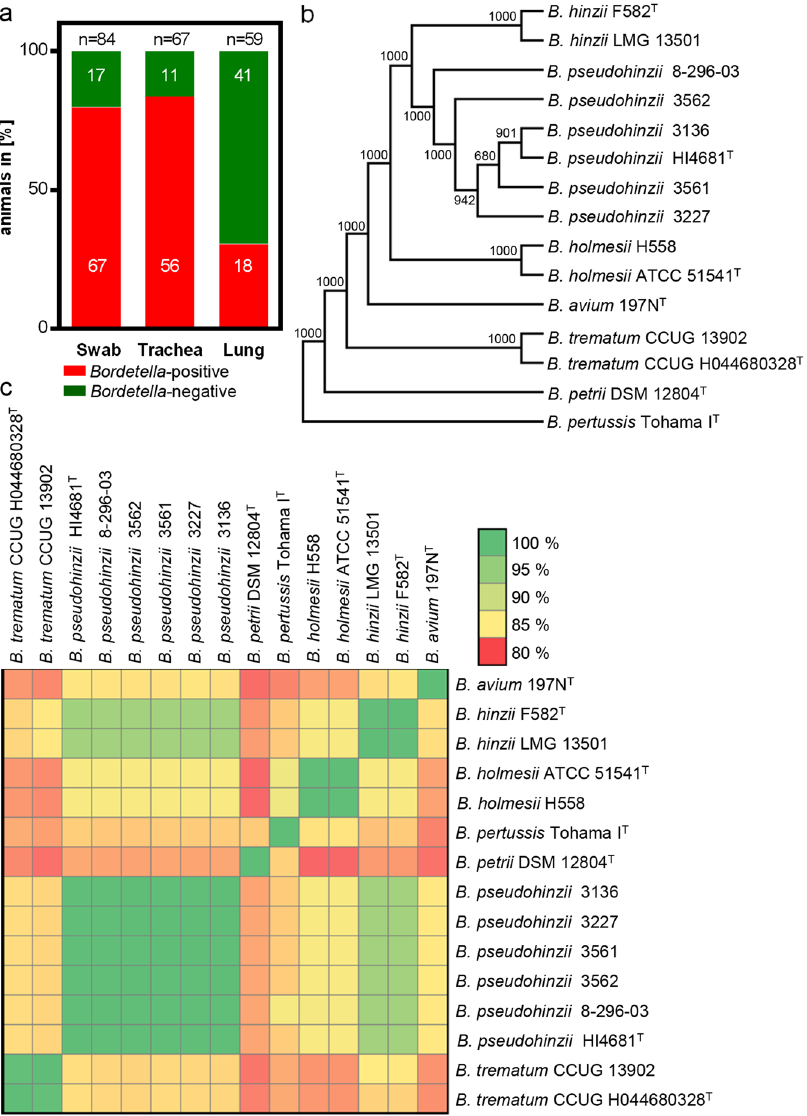
Figure 1. Occurrence of B. pseudohinzii in a laboratory mouse colony. ( a ) Prevalence of B. pseudohinzii in the oral cavity (swab), trachea and lung of mice confirmed by MALDI-TOF MS analysis and subsequent next generation genome sequencing of bacterial isolates. ( b ) Phylogenetic tree based on the amino acid sequences of 1649 core genes shared among 15 Bordetella genomes. The tree was constructed using the neighbour-joining method. Boot strap values are indicated. ( c ) Heatmap of the average nucleotide identity shared between different Bordetella